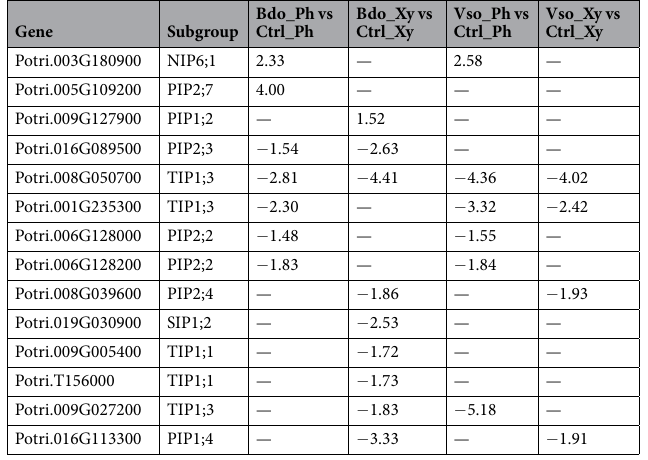
Table 4. The differentially expressed Aquaporin-encoding genes in the phloem and xylem in canker pathogens inoculated poplar